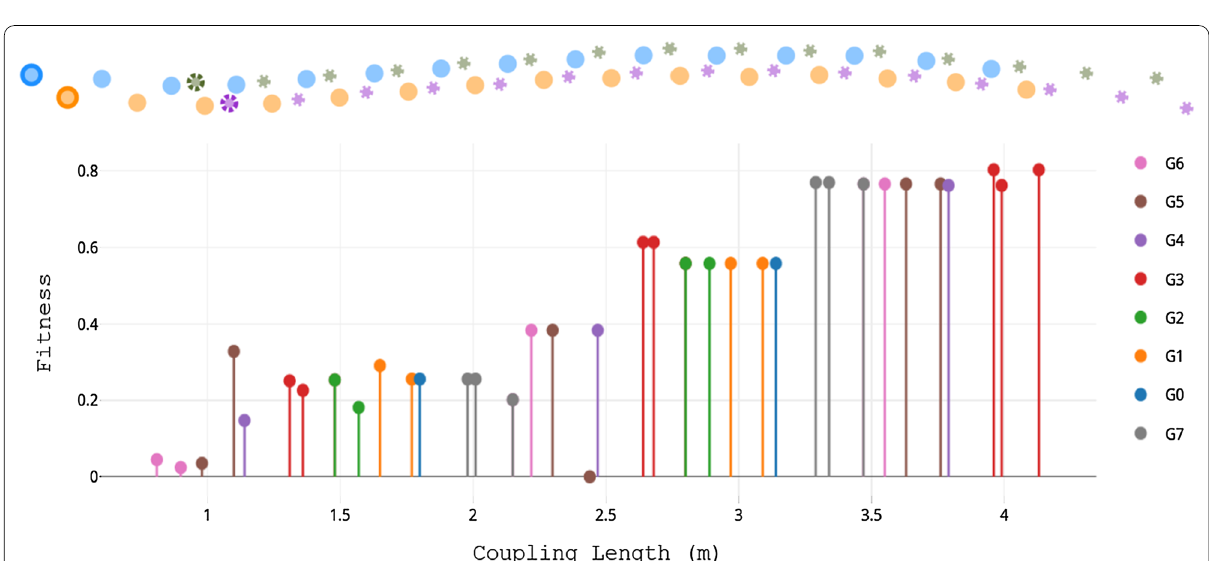
Fig. 12 The S4 trackway, a contiguous segment of BEB-500-S4, presented insufficient irregularity to provide information about the gait or size of the trackmaker based on coupling